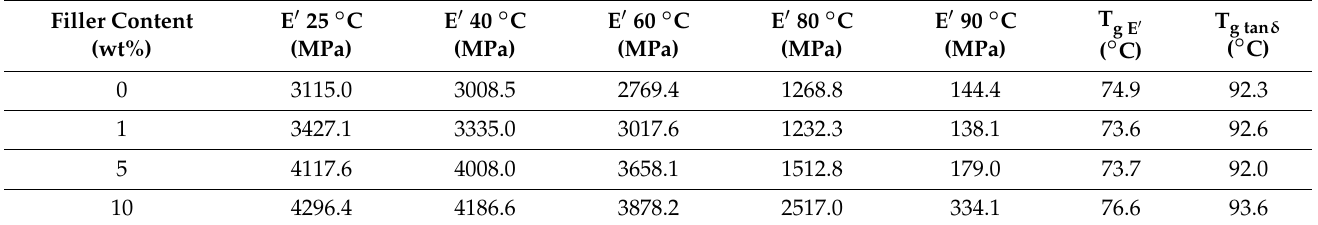
Figure 7. Storage modulus and tan δ of PVC and PVC hybrid filler composites. ( a ) Storage modulus ( b ) loss factor. Table 2. Storage modulus at different temperatures and values of T g of PVC and its